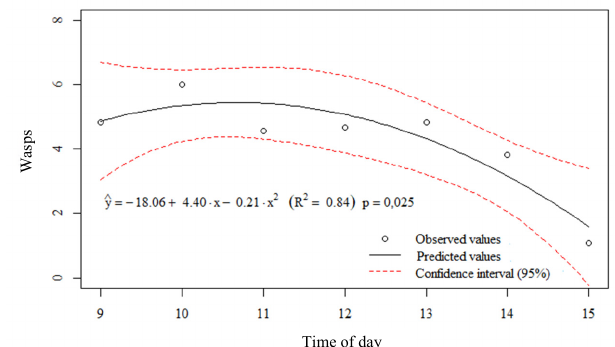
Fig 1 . Effect of time of day on average number of social wasps foraging in kale ( Brassica oleraceae var. acephala ) from July to November 2016, in Bambuí, MG.